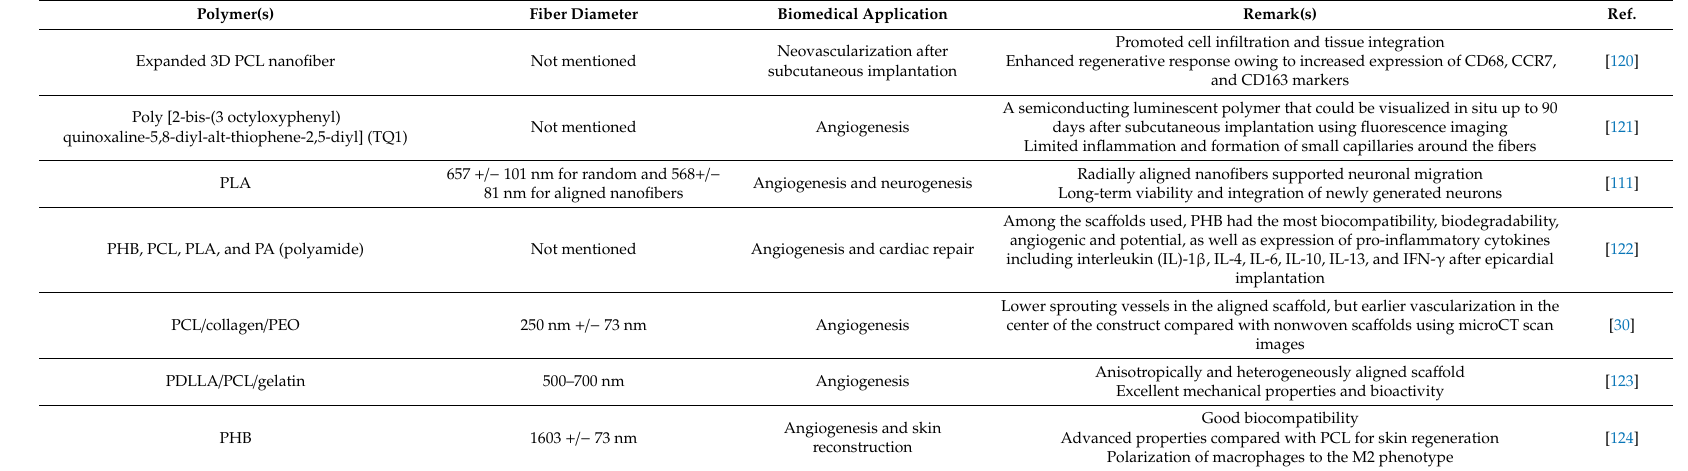
Table 4. A summary of polymeric nanofibers with the ability to promote angiogenesis. PCL, poly( ε -caprolactone); PLA, poly(lactic